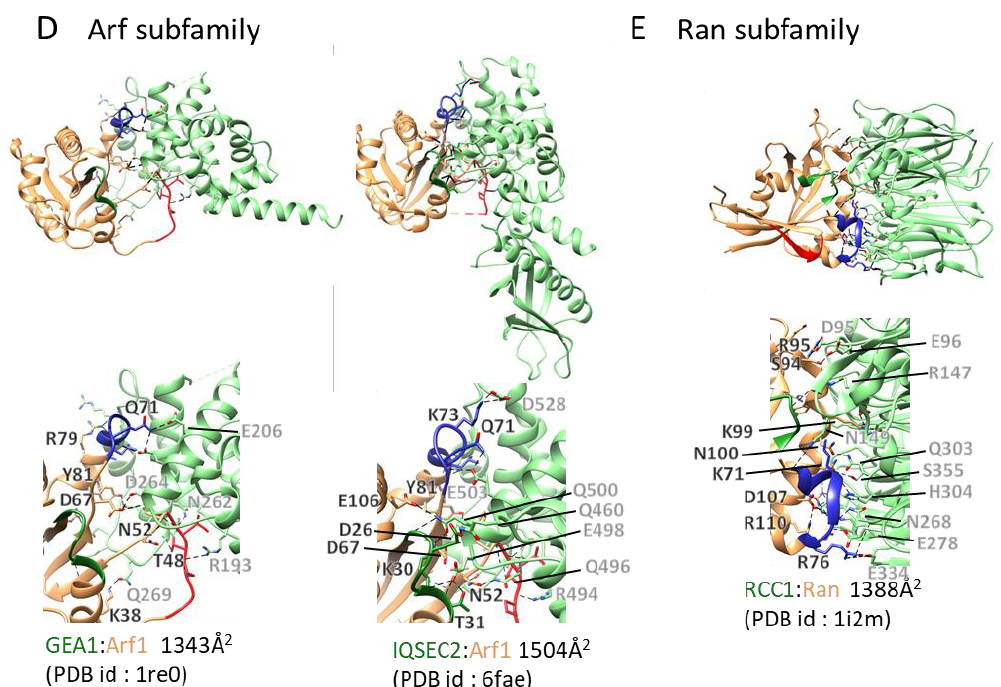
Figure 4. GEF:small GTPase complex structures and their interacting interface: GEF:small GTPase complex structures in the ligand unbound forms were drawn. The color scheme and other descriptions follow those of Figure 1B. Dashed lines depict hydrogen bonds or electrostatic interactions. The interaction areas and Protein Data Bank (PDB) ids are shown. ( A ) Ras subfamily. ( B ) Rho subfamily. ( C ) Rab subfamily. ( D ) Arf subfamily. ( E ) Ran subfamily.